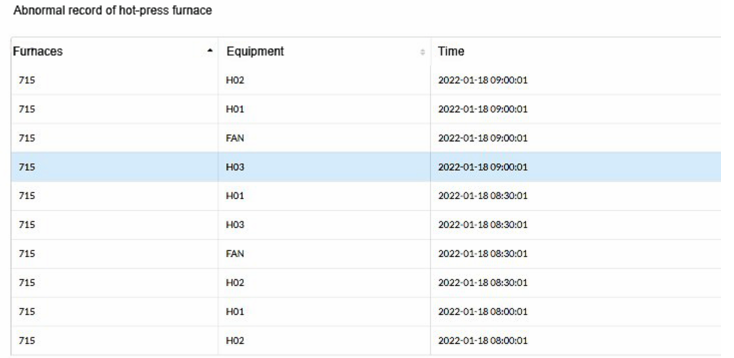
Figure 9. The abnormality record of the hot-pressing